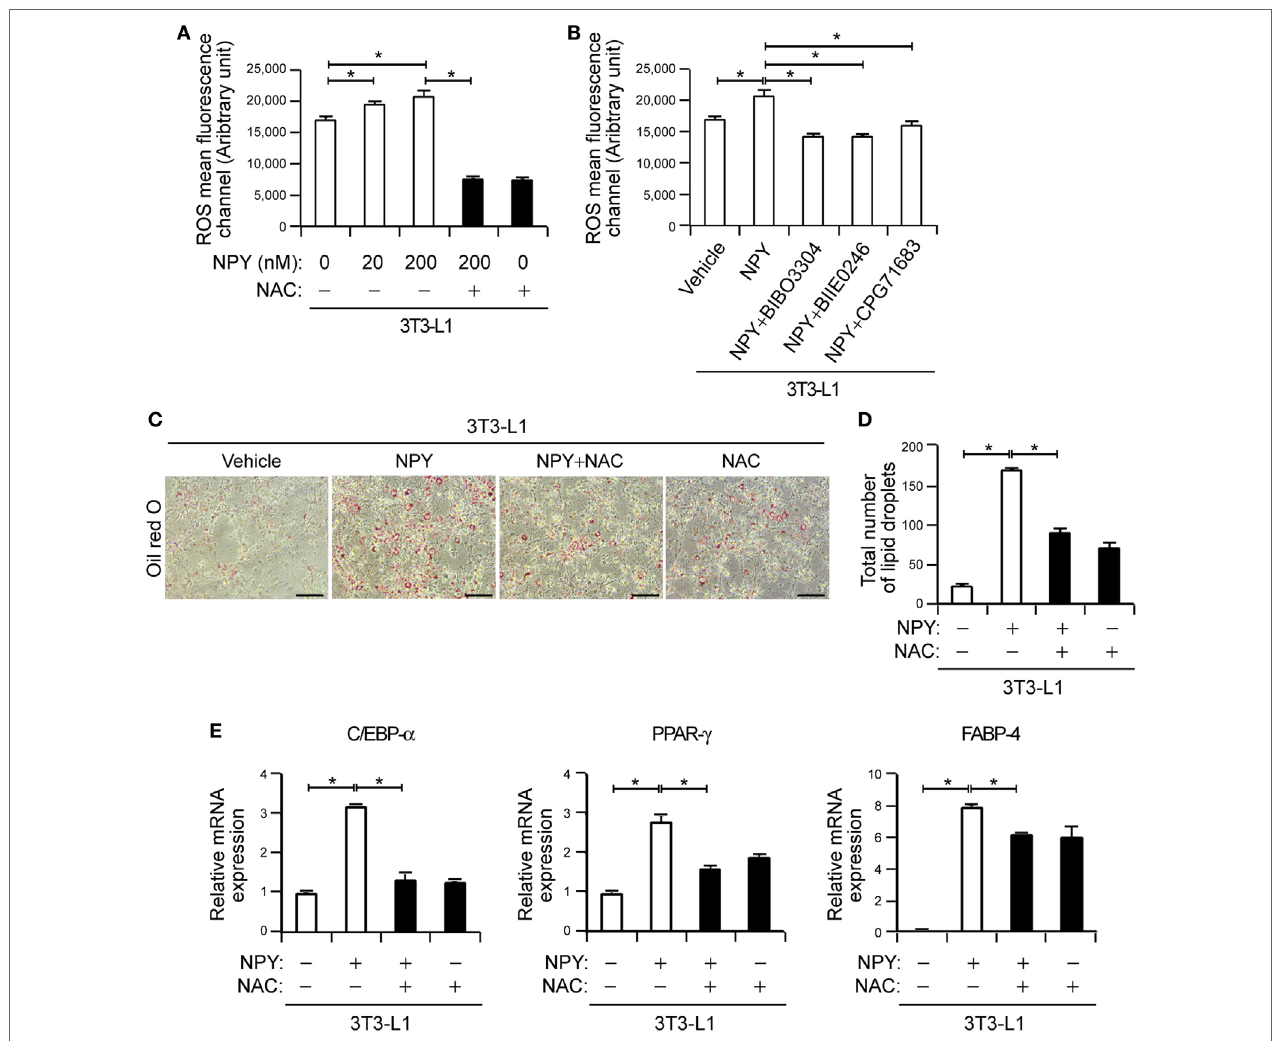
FigUre 3 | Neuropeptide Y (NPY) induces adipogenesis via reactive oxygen species (ROS) production in murine preadipocytes. (a) ROS levels were increased in NPY-treated 3T3-L1 cells. The cells were incubated with 2 ′ ,7 ′ -dichlorofluorescin diacetate (10 µM) for 30 min at 37°C and subsequently treated with the indicated concentrations of NPY with or without N -acetylcysteine (NAC, 10 mM) for 4 h. ROS levels were assessed using a FACS Canto flow cytometry system ( n = 3). (B) The pharmacological inhibition of NPYR blocks NPY-induced ROS production. 3T3-L1 cells were treated with NPY (200 nM) in the presence or absence of NPY1R antagonist (BIBO3304), NPY2R antagonist (BIIE0246), or NPY5R antagonist (CGP71683 hydrochloride) and the ROS levels were subsequently analyzed. * p < 0.05 compared with the vehicle control ( n = 3). (c) 3T3-L1 cells treated with NPY with or without NAC (10 mM) were stained with Oil-Red-O and imaged under a microscope. Scale bar: 100 microm (µM). (D) The total number of lipid droplets in (c) was quantified ( n = 5). (e) Relative mRNA levels of adipocyte differentiation markers were analyzed using quantitative real-time PCR (qPCR). qPCR data are the fold-changes in the mean vehicle control value ( n = 4). Data are representative of three independent experiments. * p < 0.05 compared with the vehicle control. p values were calculated using Kruskal–Wallis test. The data values represent the mean ±